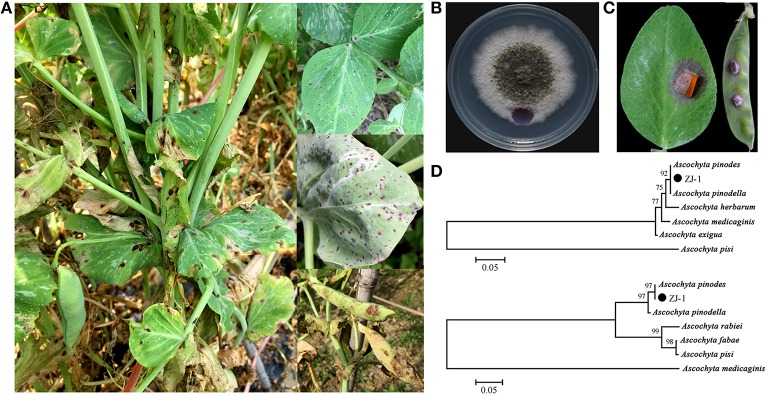
Disease symptoms of ascochyta blight of field peas and characters of representative isolate ZJ-1. (A) Typical disease symptoms of ascochyta blight on pea leaves and pods in field. (B) Colony morphology of ZJ-1 on PDA plate after 9-day incubation. (C) The disease symptoms caused by the ZJ-1 inoculums on pea leaves and pods. (D) The phylogentic tree of ZJ-1, constructed by the neighbor-joining method with Molecular Evolutionary Genetics Analysis version 4.0, based on the ITS sequence (upper) and G3PDH gene (bottom).